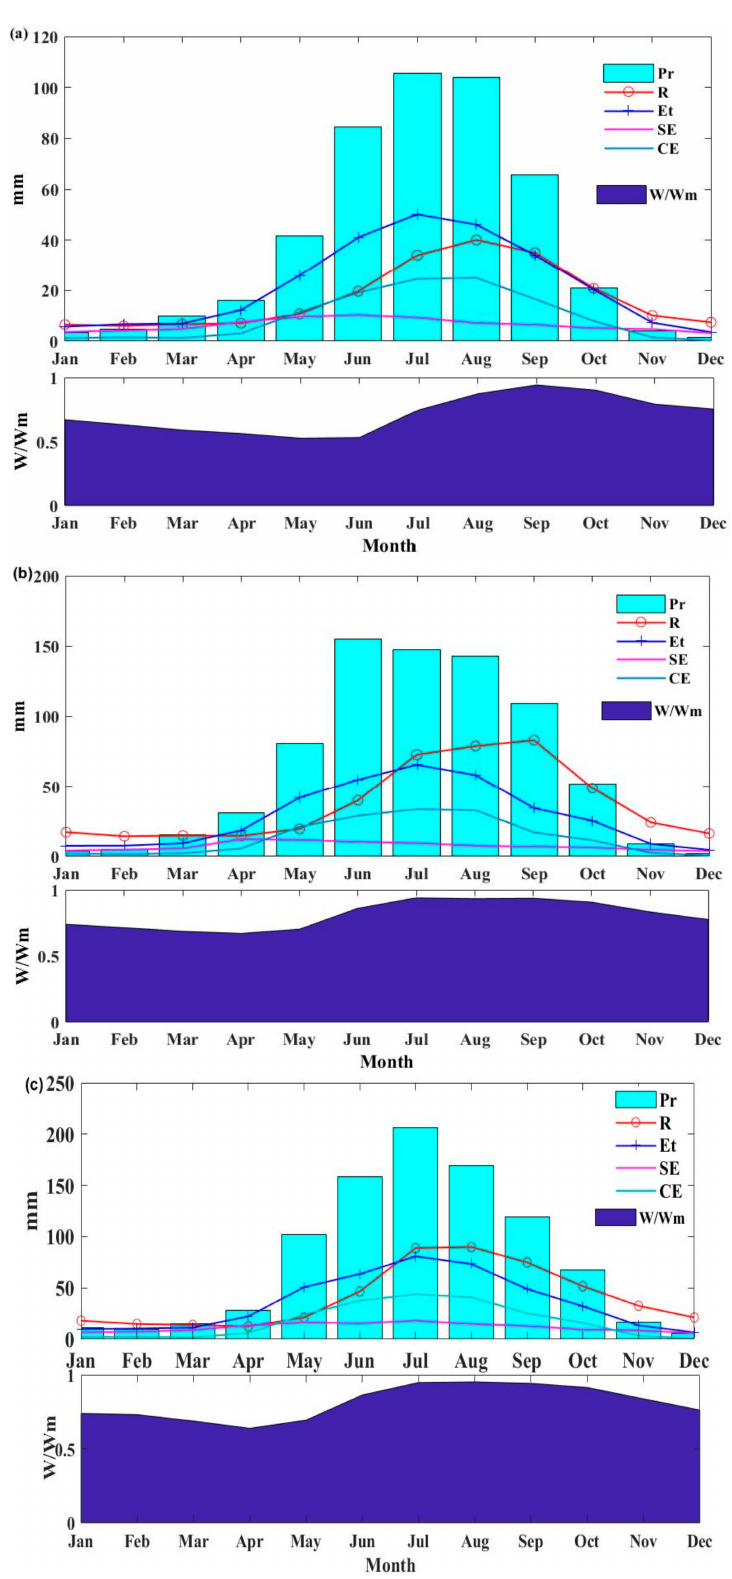
Figure 7. The series of monthly precipitation, runoff, evapotranspiration ( E t ), canopy transpiration (CT), potential soil evaporation (SE), and the ratio of mean tension water storage ( W ) to tension water capacity ( W M ); ( a ) Sub-basin 1; ( b ) Sub-basin 2; ( c ) Sub-basin